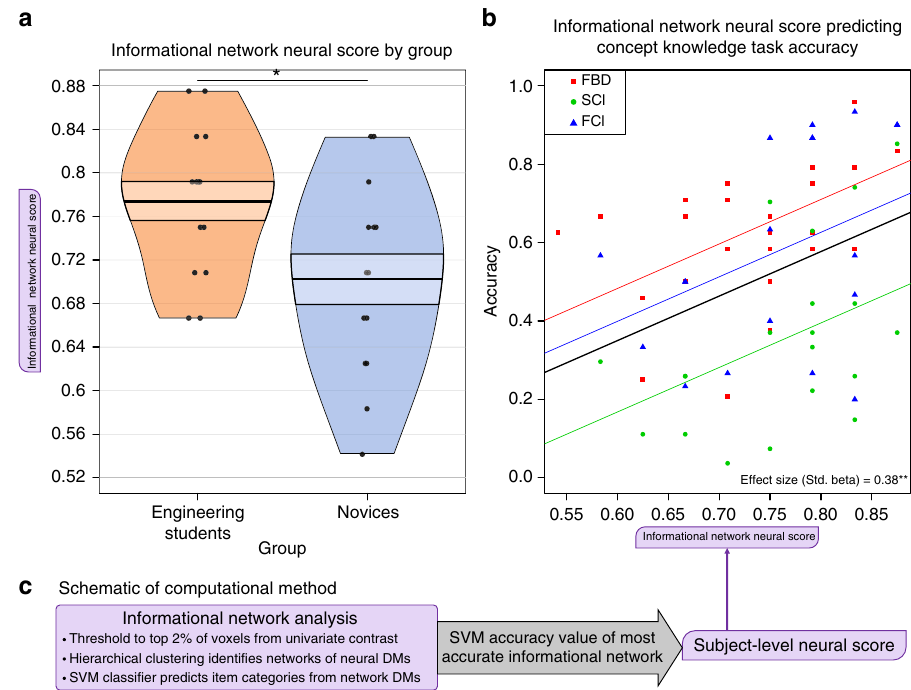
Fig. 2 Informational network neural score results. a Informational network neural score from the fi rst fMRI run signi fi cantly differentiated the participants by group. b Informational network neural score signi fi cantly predicted concept knowledge in a linear mixed-effects model. The overall regression line is plotted as the thick black line over the observed accuracy data for each outcome measure type (FBD, SCI, and FCI accuracy). Random intercepts for each outcome measure are plotted as the colored lines. Effect size (standardized beta parameter) for the regression model are printed in the lower right corner of the plot. c Schematic outlining the computational method for the informational network analysis, used to compute the informational network neural score for each participant. (For between-group t test signi fi cance value at left and mixed-effects regression coef fi cient signi fi cance value at right: * = p < 0.05, ** = p < 0.01, *** = p <